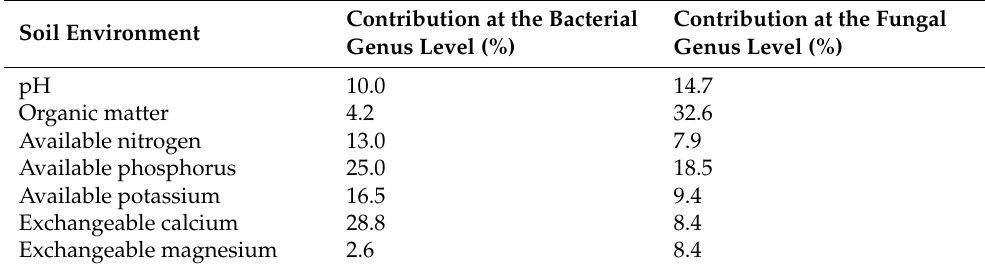
Table 4. Contribution of soil environment to bacteria and fungi taxa at the genus